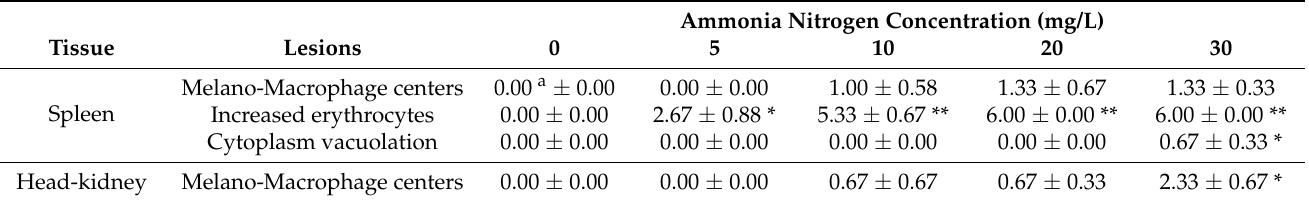
Table 1. Quantitative analysis of histopathological changes in the spleen and head-kidney of M. amblycephala under chronic ammonia exposure.